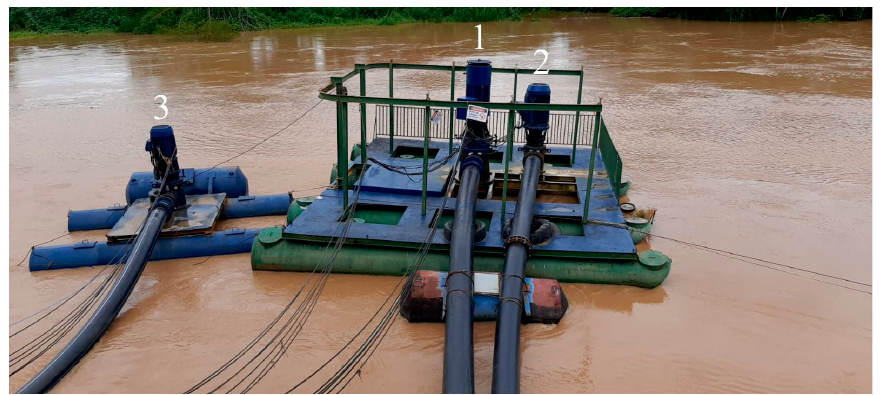
Figure 1. Schematic representation of the activities developed in this work.